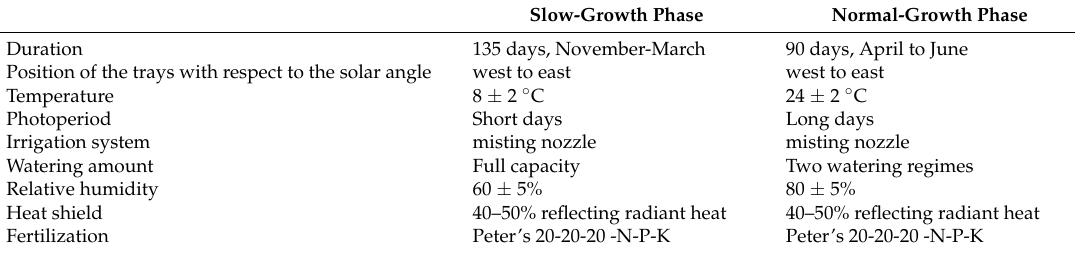
Table A1. Phases and greenhouse conditions for species